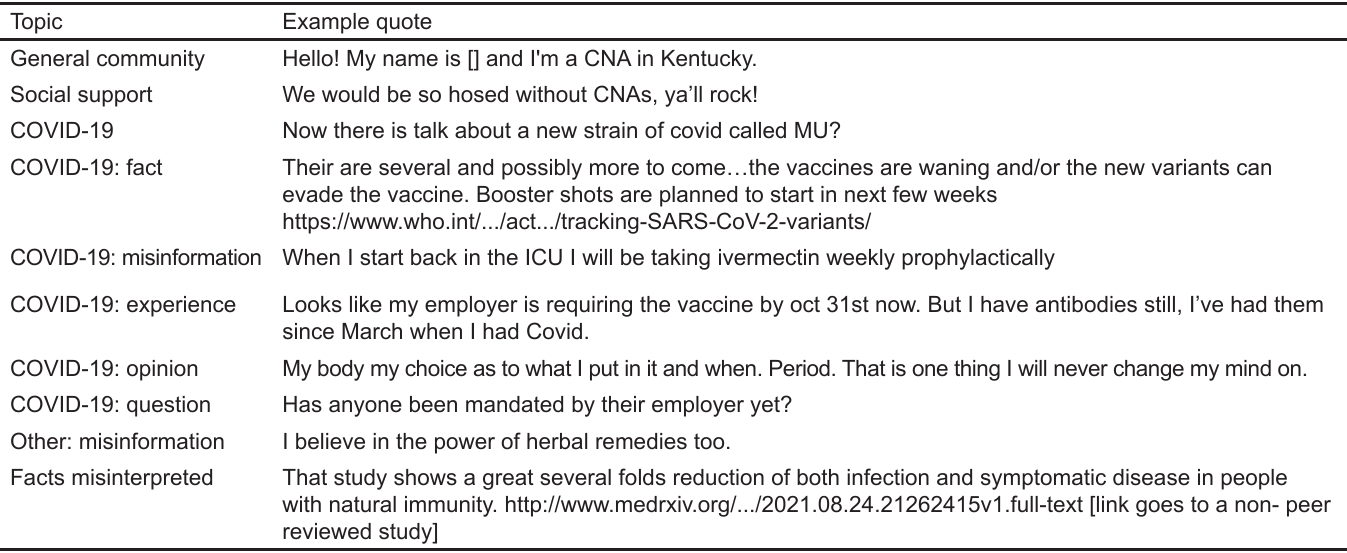
Table 1. Example quotes of each topic. Each topic category is non-exclusive; so, posts and comments can potentially be labeled as all topics. Example quotes were shortened to the relevant text that represented a topic.